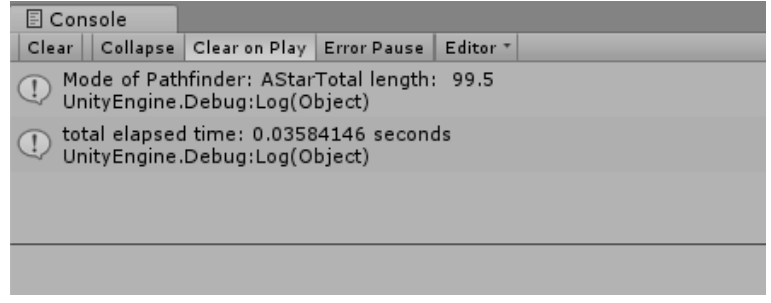
Figure 24. Result using Dijkstra Algorithm (1).